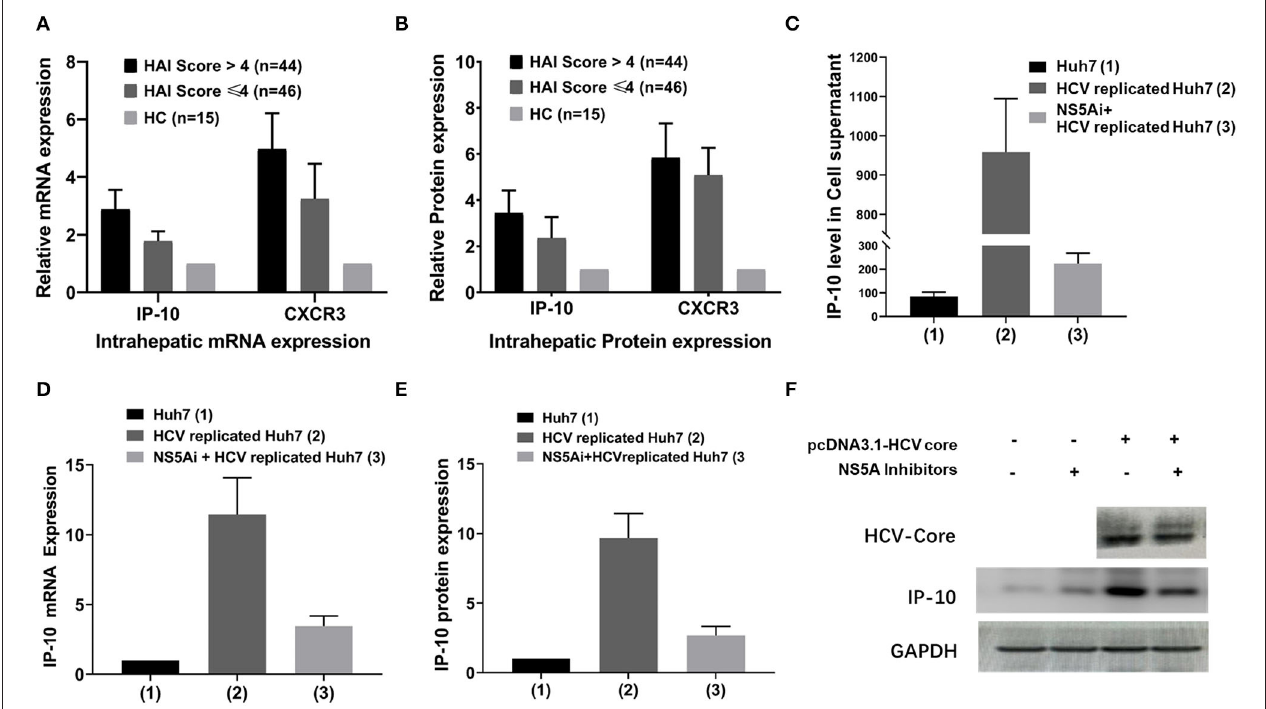
FIGURE 3 | Differential IP-10 mRNA and protein expression in hepatic tissue and cultured Huh7 cells. (A) Intrahepatic IP-10 and CXCR3 mRNA expression in HCV-infected patients was higher than in HCs, and it was higher in HAI > 4 subgroup than in HAI ≤ 4 subgroups ( p < 0.001); (B) Intrahepatic IP-10 and CXCR3 protein expression in HCV-infected patients was higher than in HCs, and it was higher in HAI > 4 subgroup than in HAI ≤ 4 subgroup too ( p < 0.001). (C) The level of IP-10 concentration in cell culture supernatants was the highest in HCV-replicated-Huh7 cells ( p < 0.001), but it can be mostly restored by NS5A inhibitor. (D,E) Expression of IP-10 mRNA and protein in cultured Huh7 cells, with the highest in HCV-replicated-Huh7 cells, can also be mostly restored by NS5A inhibitor. (F) The representative immunoblotting band for IP-10 protein in HCV-replicated-Huh7 cells; the results of visual effects are consistent with the data expression of